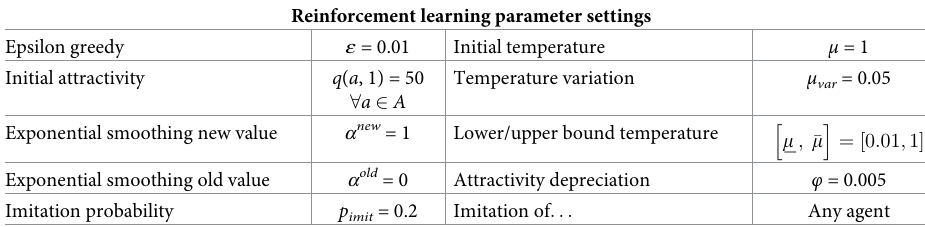
Table 4. Parameter settings of the reinforcement learning